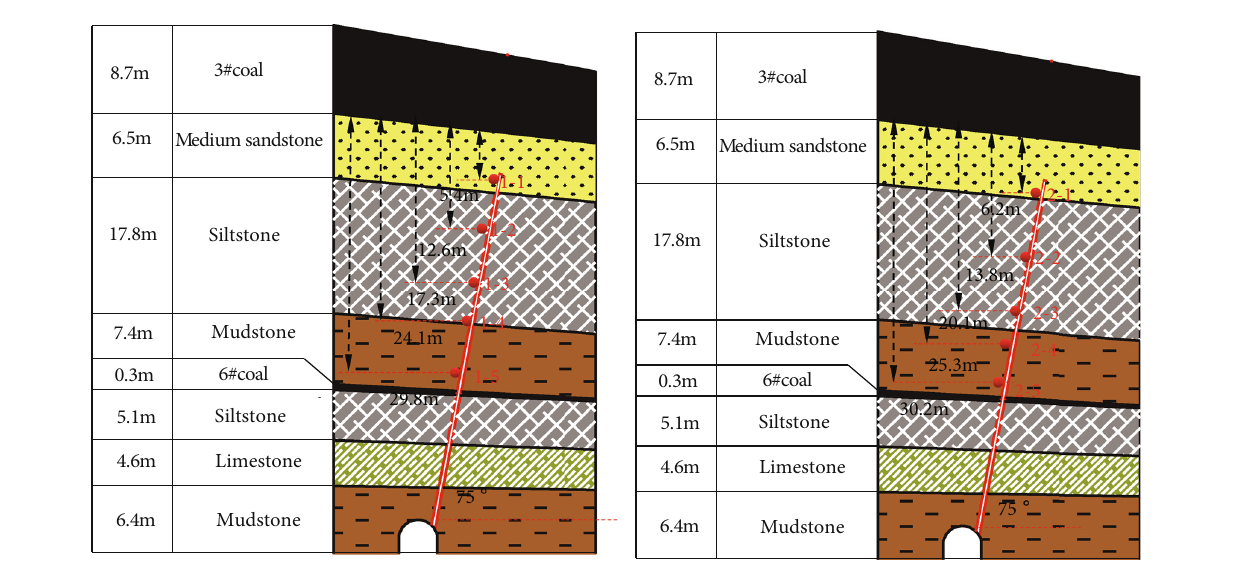
Figure 4: Layout of strain boreholes. Table 1: Design parameters of the